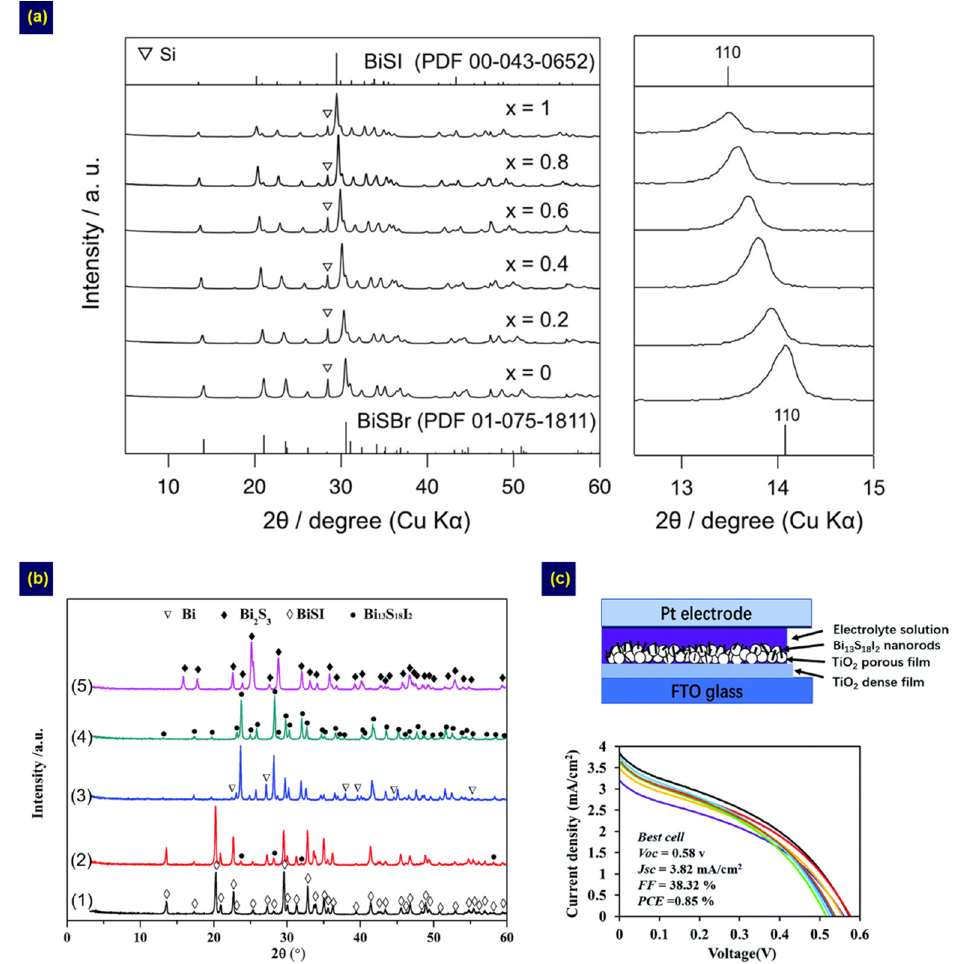
Figure 7. ( a ) Structures of the BiSBr 1 − x I x obtained from BiOBr 1 − x I x under H 2 S gas at 150 °C. Adapted under the terms and conditions of the CC BY license [41], copyright 2016, the authors. Adapted from [41], from Springer Nature, 2016. Structure and device performance for the Bi-S-I compounds synthesized by the solvothermal method: ( b ) Plot showing the effects of the CH 4 N 2 S/BiI 3 /MAI molar ratio including (1) 1:2:3, (2) 2:2:3, (3) 3:2:3, (4) 4:2:3, and (5) 8:2:3 on structures. ( c ) Schematic diagram and J – V curves of Bi 13 S 18 I 2 solar cells. Adapted from [53], with permission from Royal Society of Chemistry, 2020.